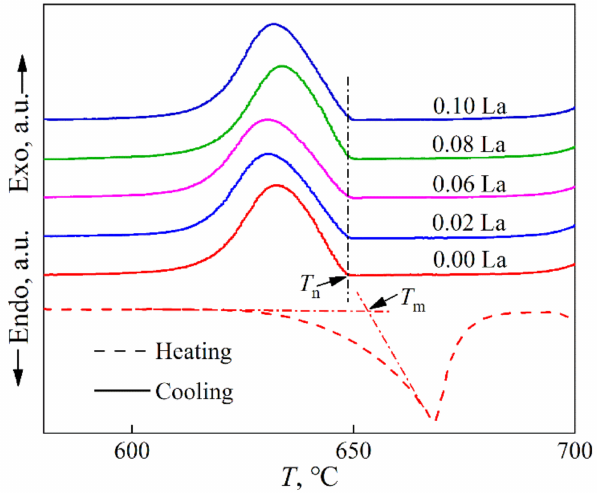
Figure 5. DTA heating and cooling curves for Al-2Cu alloy inoculated with 0.4% Al-5Ti-1B vs. La addition level. T n and T m are respectively the nucleation temperature and melting temperature. Heating/cooling rate is 10